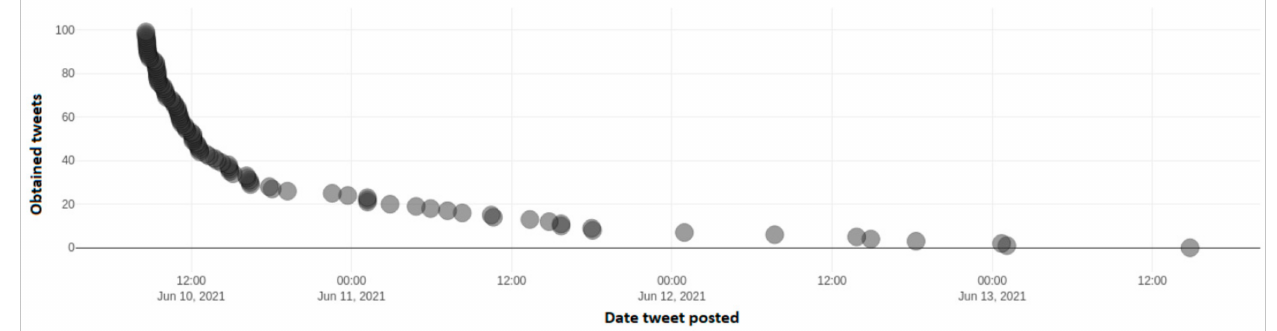
Figure 23. Mined tweets based on positive hashtag (# σηκ ´ ω ν o υµε _ µαν ´ ι κια ) (100 tweet sample) for government Covid-19 restriction measures.